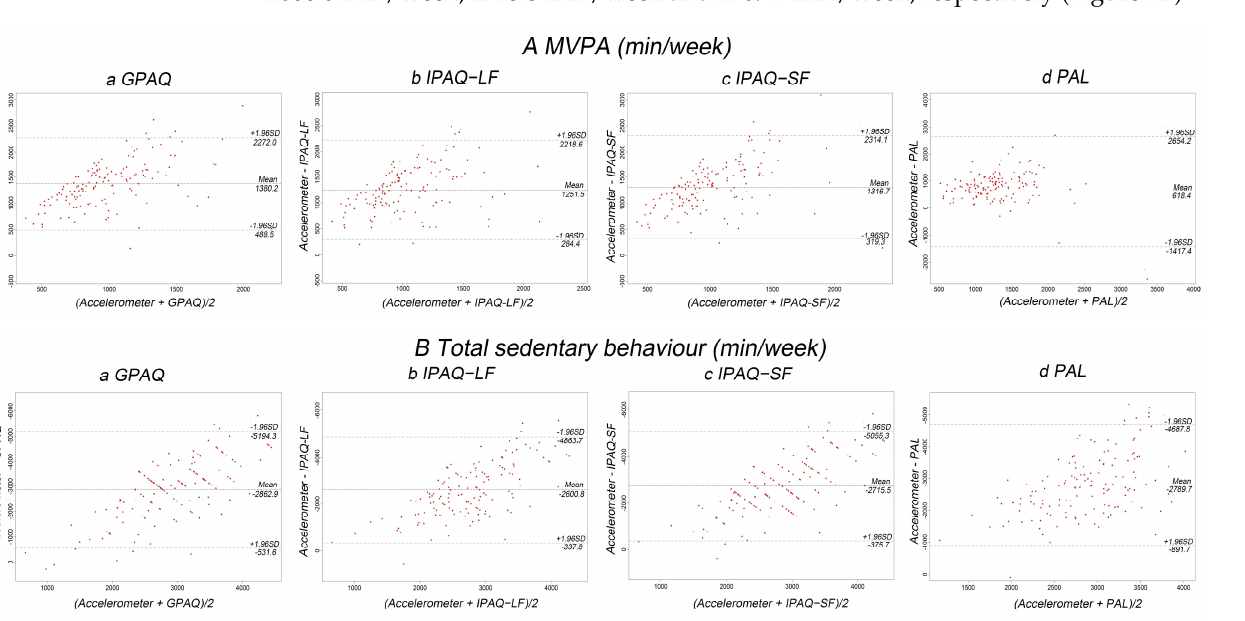
Figure 1. Bland–Altman plots of the validity of the GPAQ, IPAQ-LF, IPAQ-SF, physical activity log and accelerometer. Abbreviation: GPAQ, Global Physical Activity Questionnaire; IPAQ-LF, International Physical Activity Questionn aire-Long Form; IPAQ-SF, International Physical Activity Questionnaire- Short Form; ( A ): Agreement of moderate and vigorous physical activity of questionnaires with accelerometer, for a, GPAQ, b, IPAQ-LF, c, IAPAQ-SF and d, PAL, respectively; ( B ): Agreement of total SB with accelerometer, for a, GPAQ, b, IPAQ-LF, c, IAPAQ-SF and d, PAL,